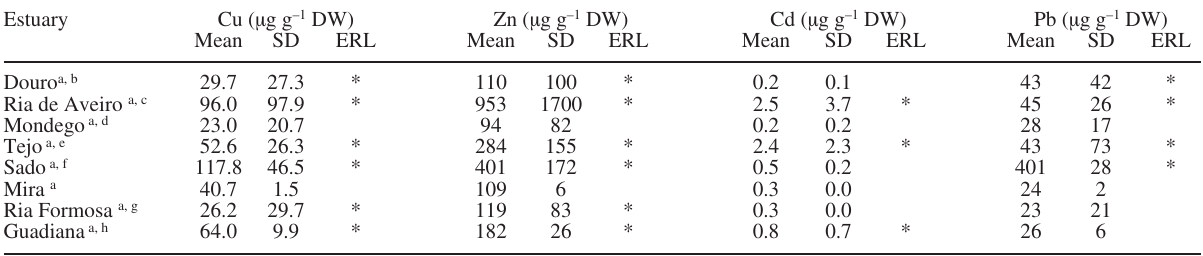
Table 1. – Mean sediment contamination by trace metals (Cu, Zn, Cd and Pb expressed in µg g –1 DW) (and standard deviation, SD), in the fine sediment fraction (<63 µm) of sampled sites within eight estuarine systems located along the Portuguese coast. Sites with samples with concentrations above Effects Range Low (ERL) [i.e. concentrations at which occasional effects on resident organisms occur according to Long et al . (1995)] are identified with an asterisk. Estuary